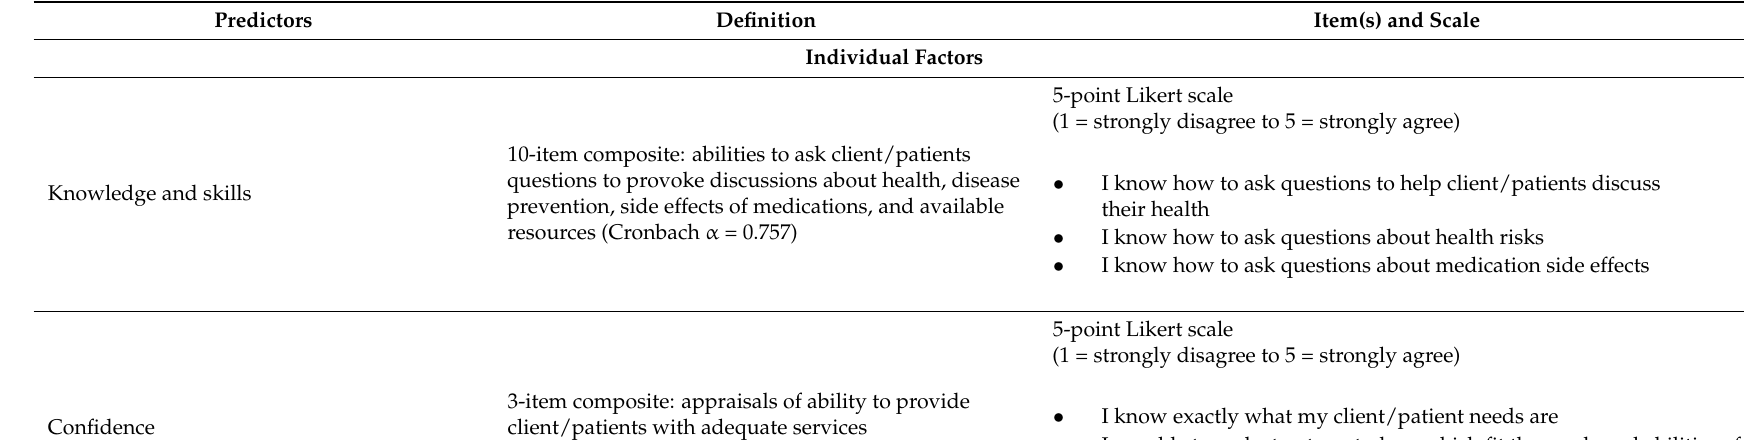
Table 1. Predictors of Service